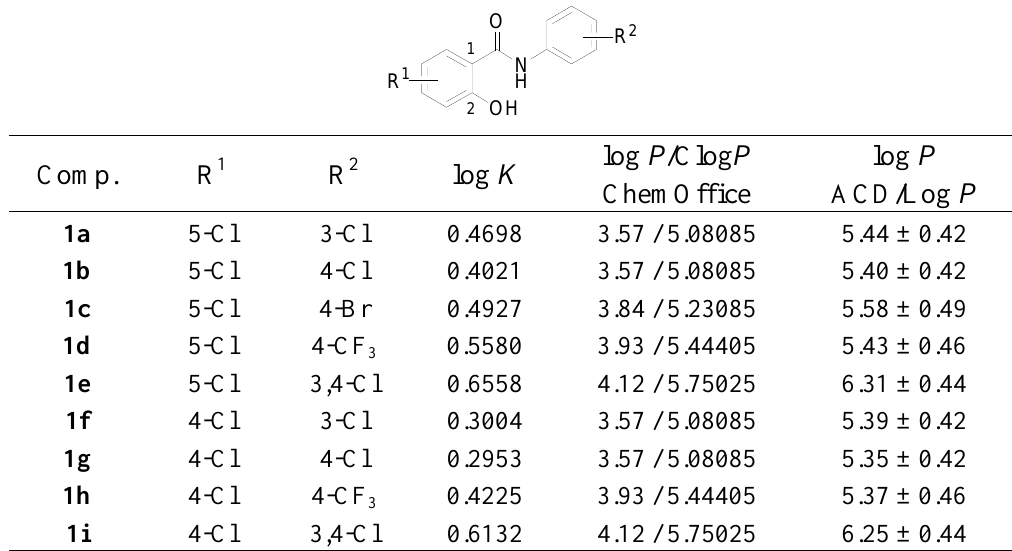
OHO R 2 N R 1 H